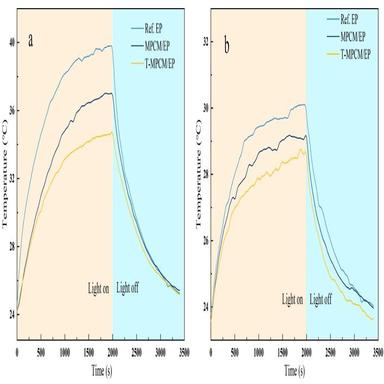
The temperature data on the wall and indoor space of the mini-room model a and b.